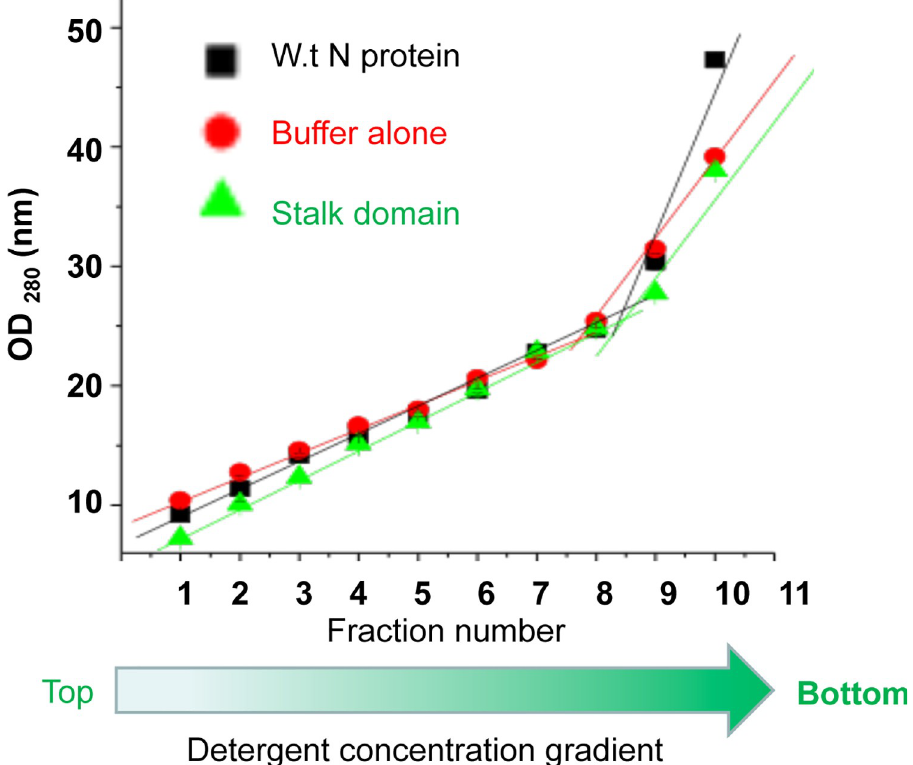
Fig 3. The absorbance at 280 nm of the fractions 1–10 from buffer alone (red), wild type N protein (black) and stalk domain (green) were recorded and plotted verses fraction number. The data points (fractions 1–7) and (fractions 8–10) were separately fit to straight lines, showing two different